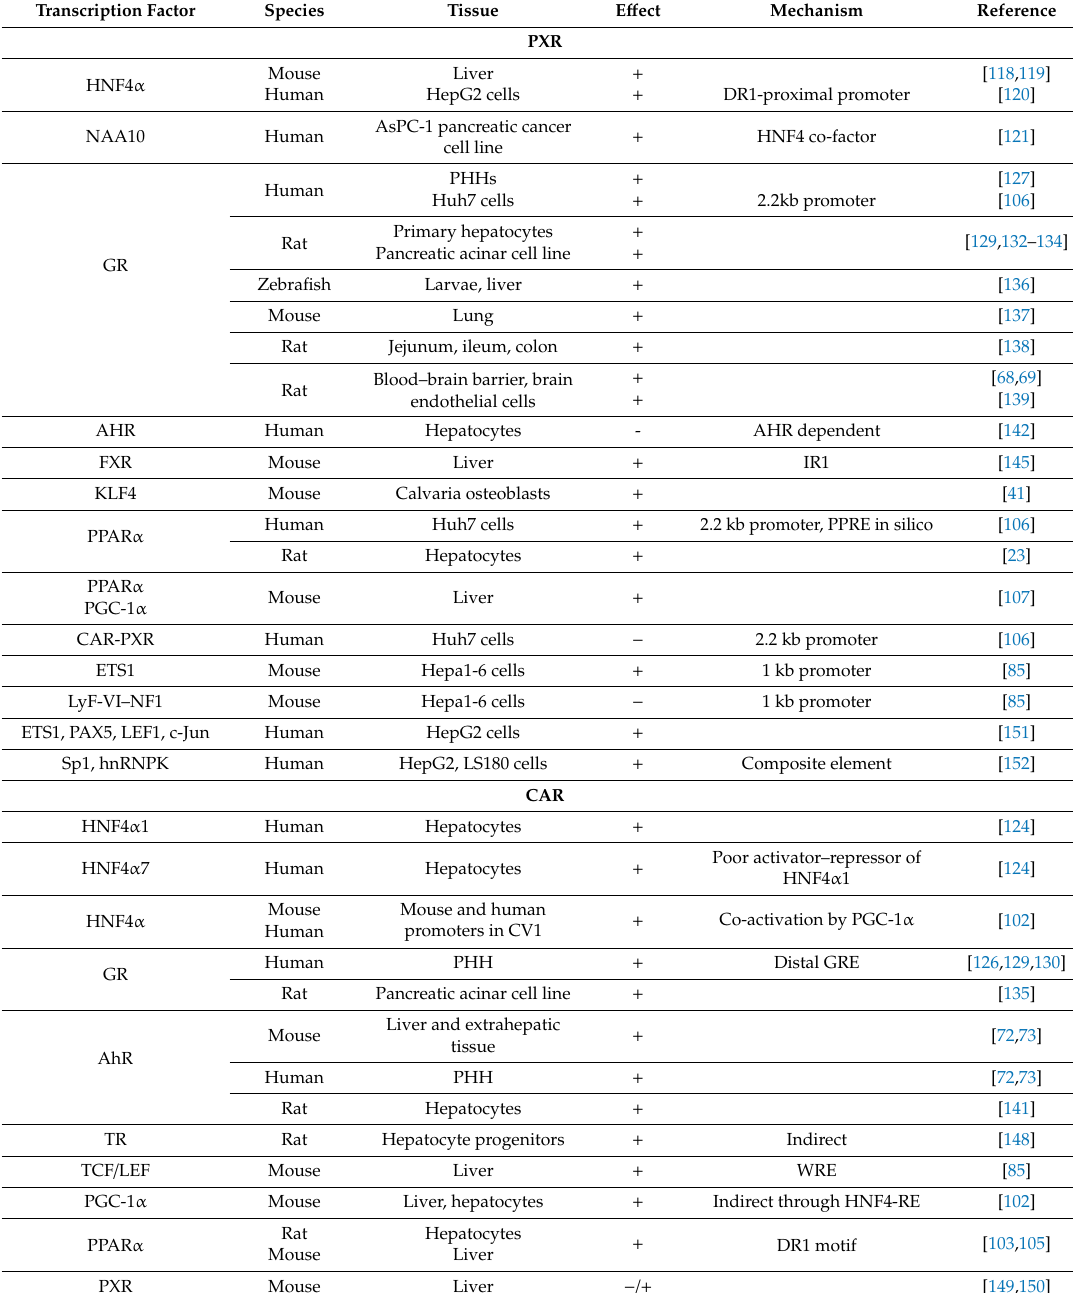
Table 1. Transcription factors that regulate CAR and PXR